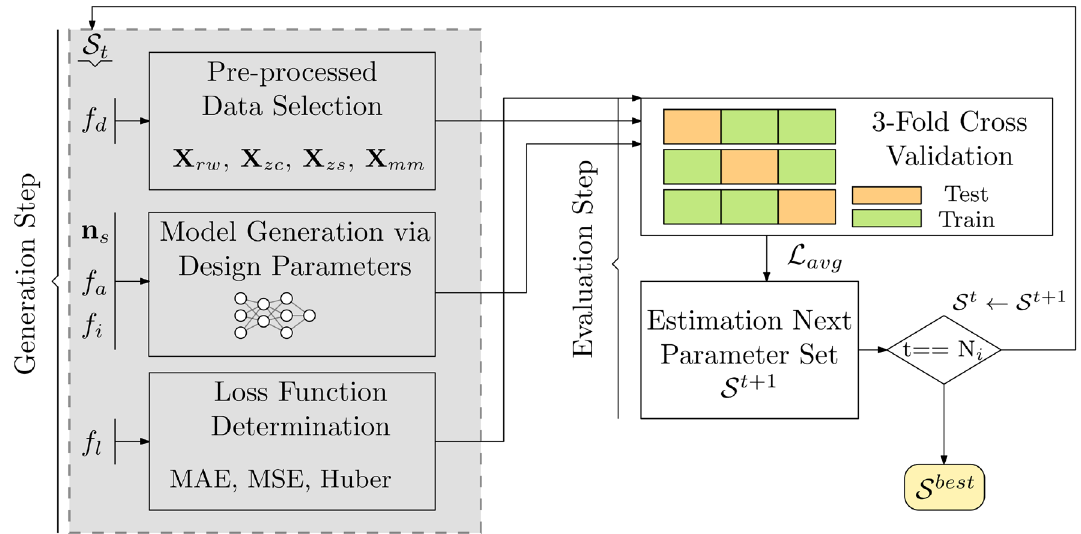
Figure 2. Training of TPE-based FARM model. First, according to the S t set data type, model architecture and loss function are determined in the Generation Step. Afterwards, TPE is executed using threefold cross validation MAE average in the Evaluation Step. Based on the evaluation, the new parameter set S t +1 is calculated. The best configuration obtained after N i iterations is selected to be the final parameter setup S best . In this study, N i = 50. The overall procedure illustrated in the figure is referred to as the FARM Searching Process .